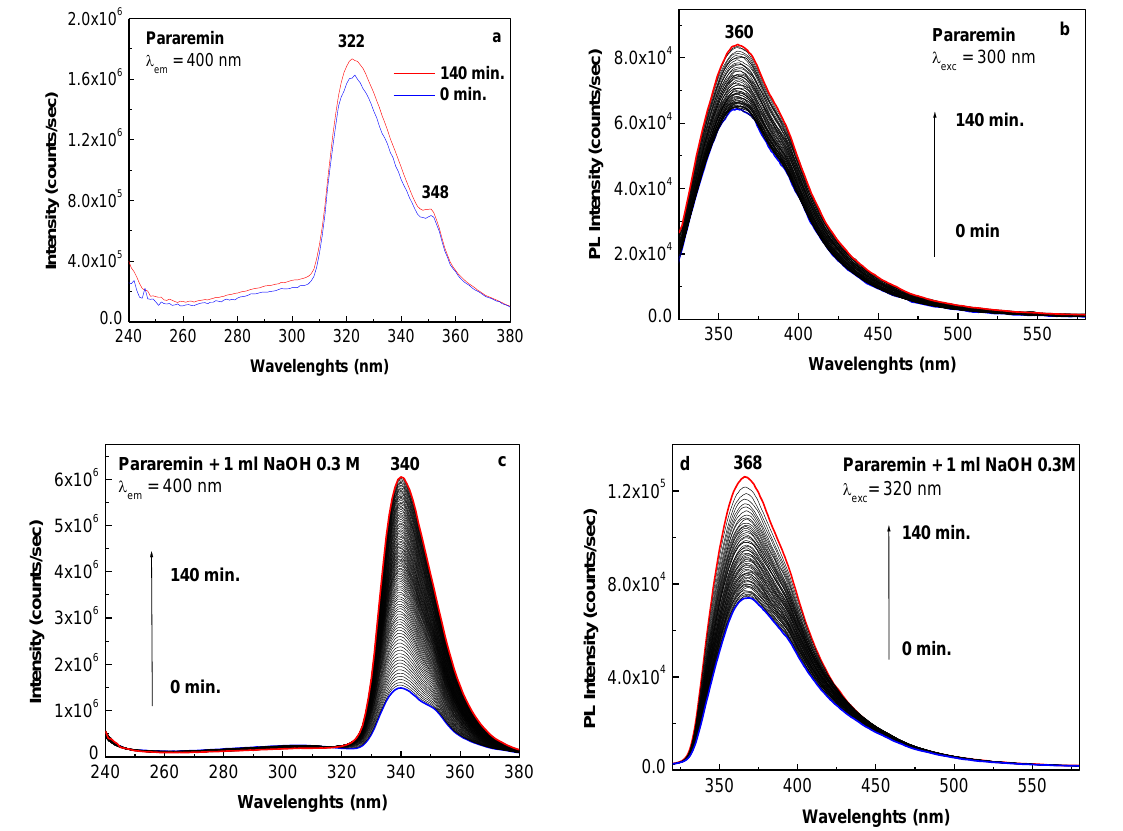
Figure 5. The PLE and PL spectra of the aqueous solution of Pararemin before ( a , b ) and after the interaction with the aqueous solution of NaOH 3 × 10 − 1 M ( c , d ). Blue and red curves correspond to the first and last spectrum, respectively, of the samples exposed to UV light for 0 and 140 min. Black curves correspond to the intermediate spectra of above samples, each PLE and PL spectrum being collected at 84 and 140 s, respectively.